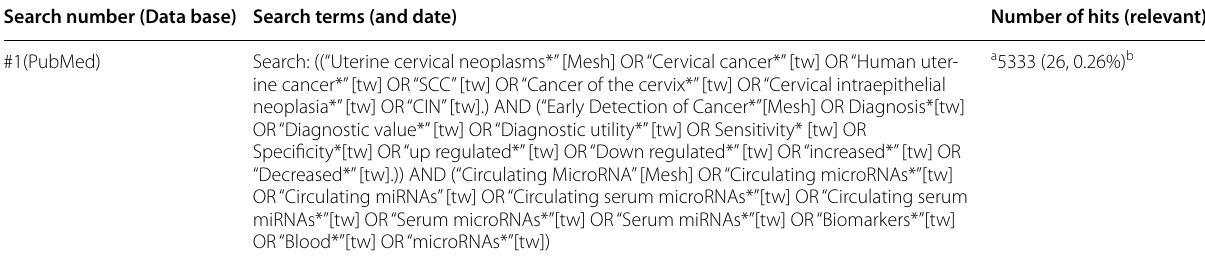
Table 2 Feasibility of yield of literature of pilot electronic search strategy for diagnostic utility of Serum microRNAs in detection of cervical intraepithelial neoplasia and cervical